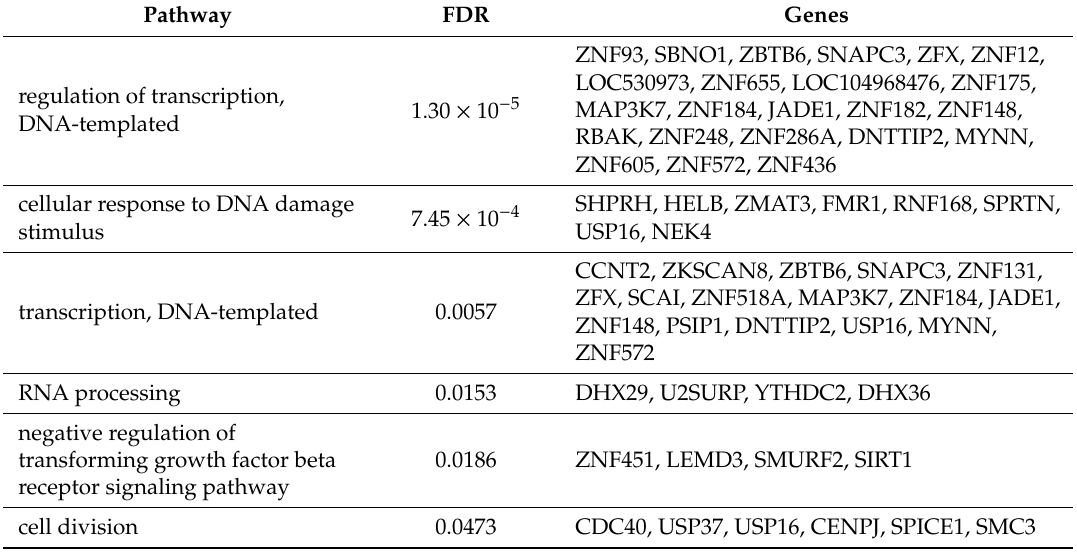
Table 2. List of significantly enriched pathways obtained using the downregulated genes following iodine supplementation.